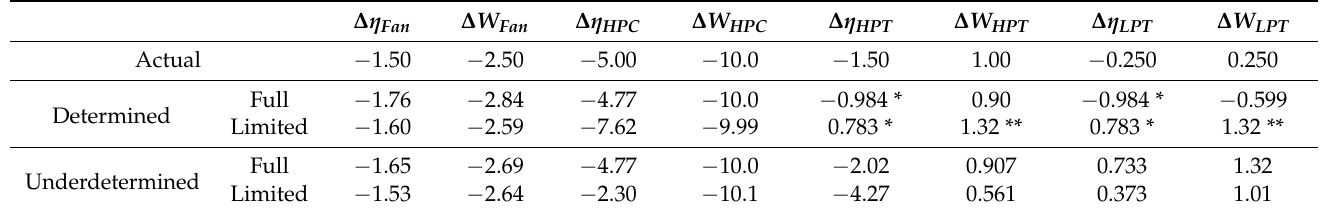
Table 10. Actual and estimated degradation patterns, with measurement noise. * Efficiency equal hurt assumed. ** Flow capacity equal hurt assumed.